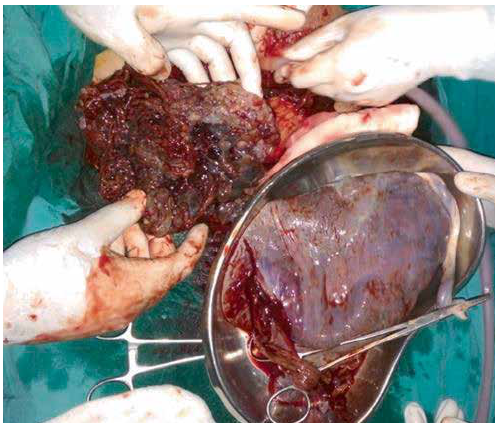
Figure 3: Normal placenta and second sac showing placenta with grape like vesicles and no fetal